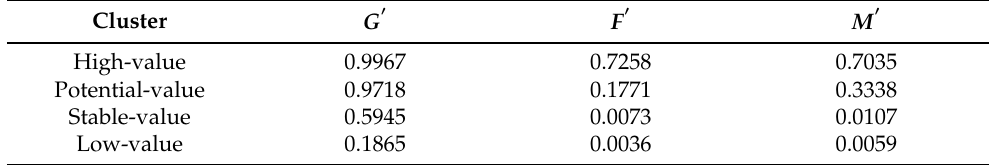
Table 3. True centers of target domain.